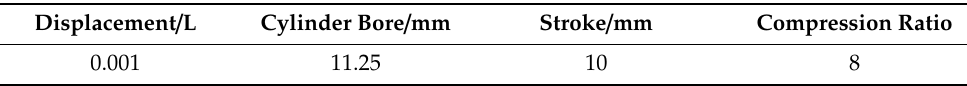
Table 1. The basic parameters of engines.